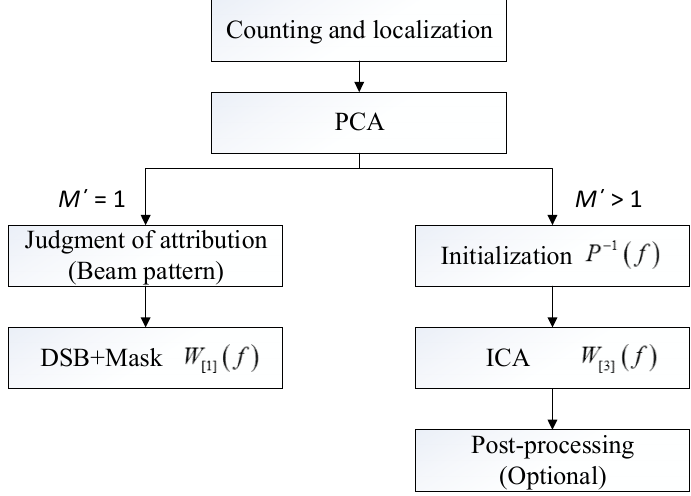
Figure 3. Flow chart of speech separation according to mixing conditions.